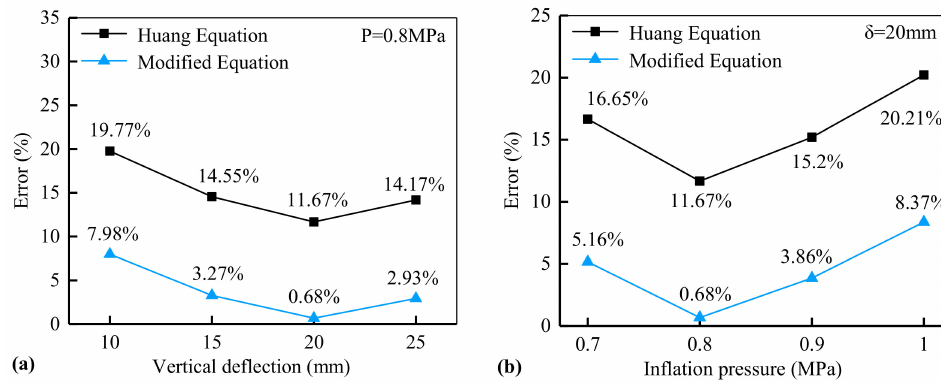
Figure 14. Estimation error of truck tire contact force: ( a ) different deflection, ( b ) different infla- tion